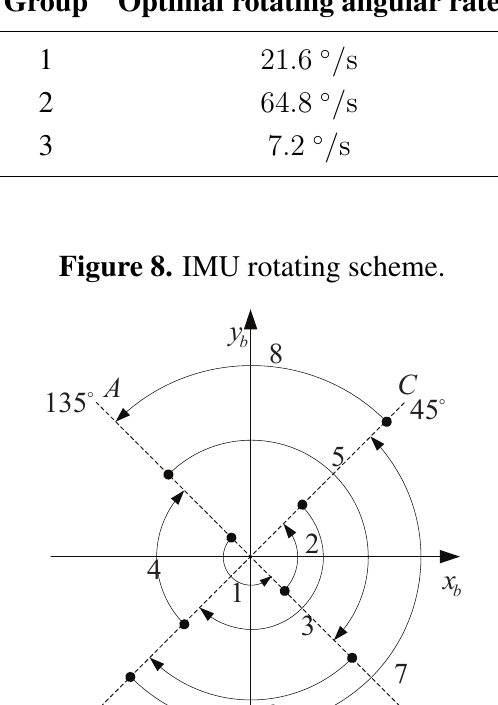
Table 4. Optimal rotating rates with different simulation conditions.